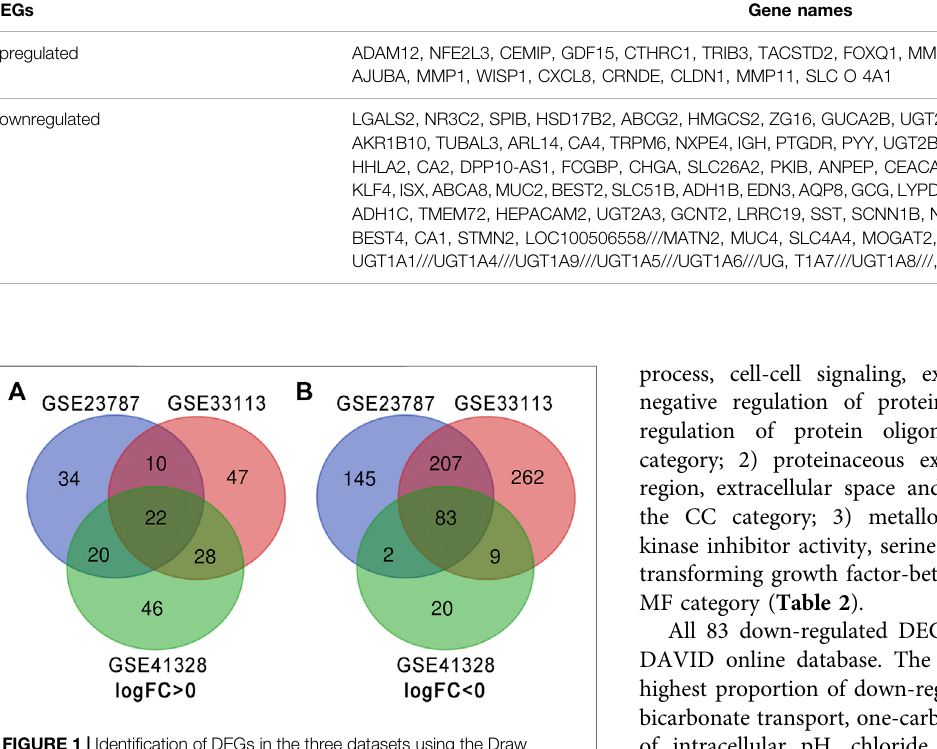
FIGURE 1 | Identi fi cation of DEGs in the three datasets using the Draw Venn diagram software. Three datasets (GSE33113, GSE23878, and GSE41328)wereused and indicatedbydifferent colors.Theoverlappingarea indicatedcommonDEGs. (A) Twenty-twoDEGswereup-regulatedinall three datasets (logFC > 0). (B) Eighty-three DEGs were down-regulated in three datasets (logFC <